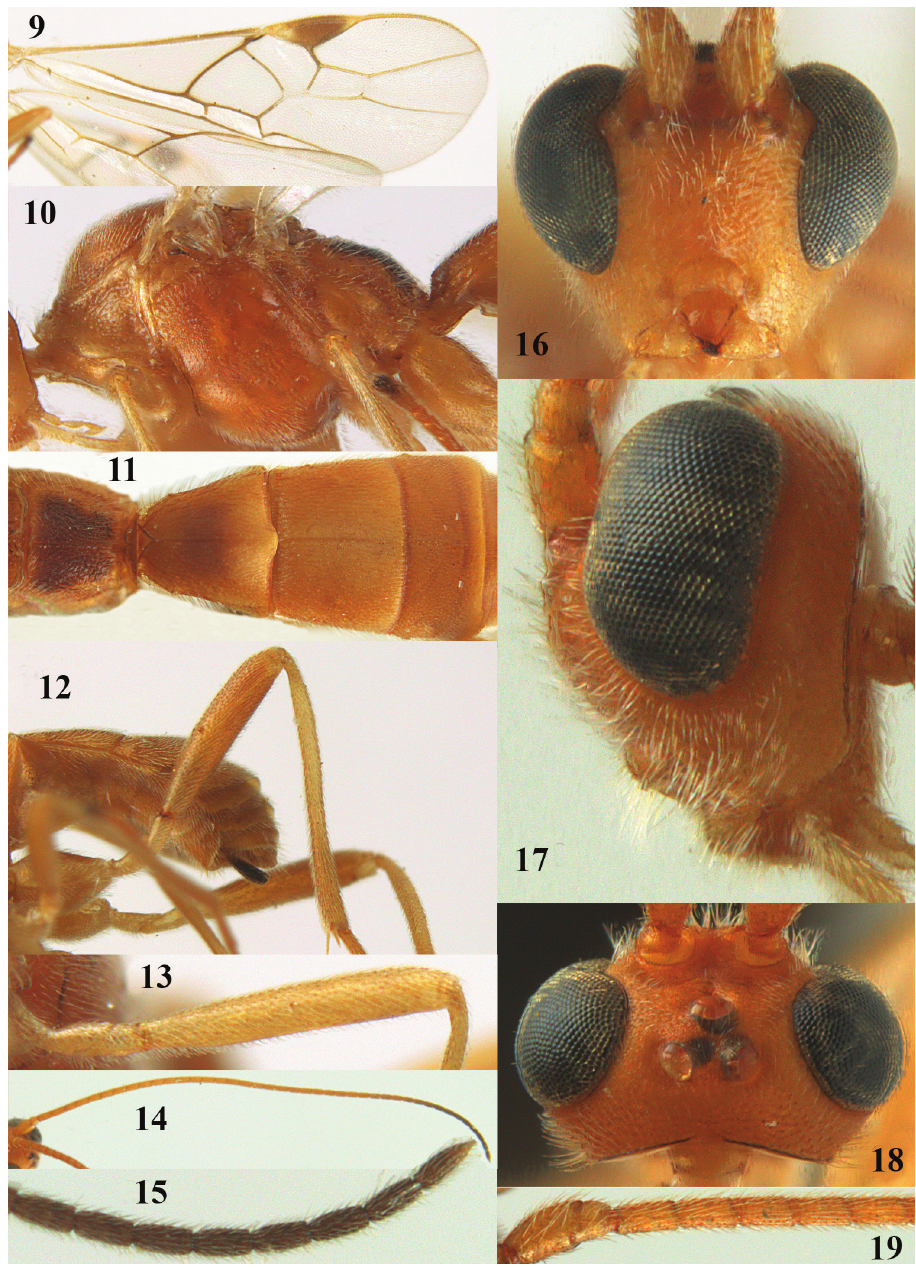
Figures 9–19. Aleiodes abraxanae sp. n., ♀ , holotype. 9 wings 10 mesosoma lateral 11 propodeum and anterior half of metasoma dorsal 12 hind leg lateral 13 fore femur lateral 14 antenna 15 apical segments of antenna 16 head anterior 17 head lateral 18 head dorsal 19 basal segments of